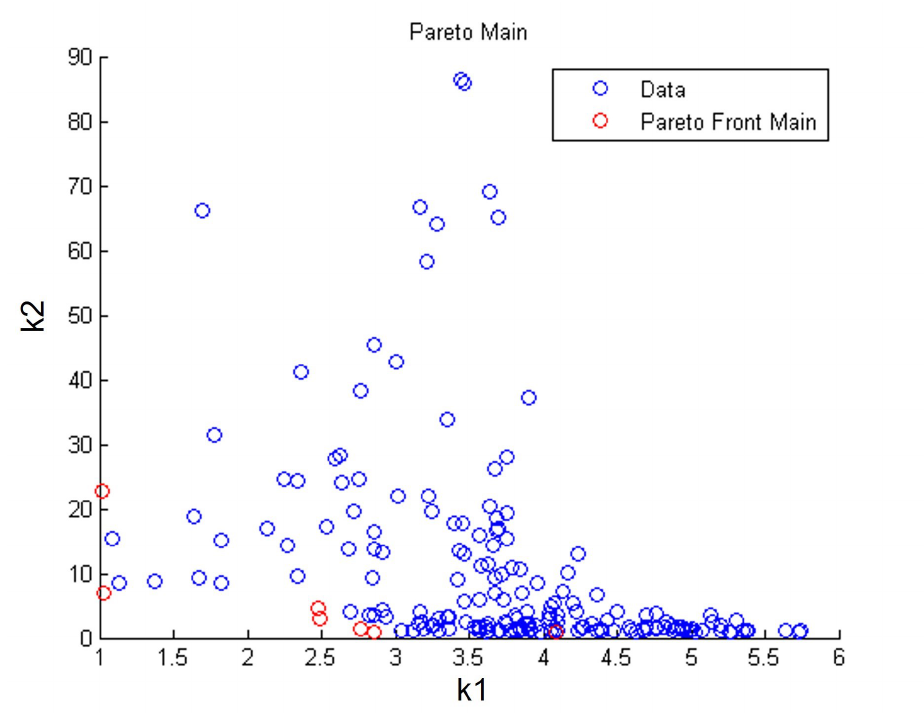
Figure 15. Pareto-optimal individuals with Pareto front; k1—calculated value of the strength proper- ties criterion; k2—calculated value of the blood perfusion